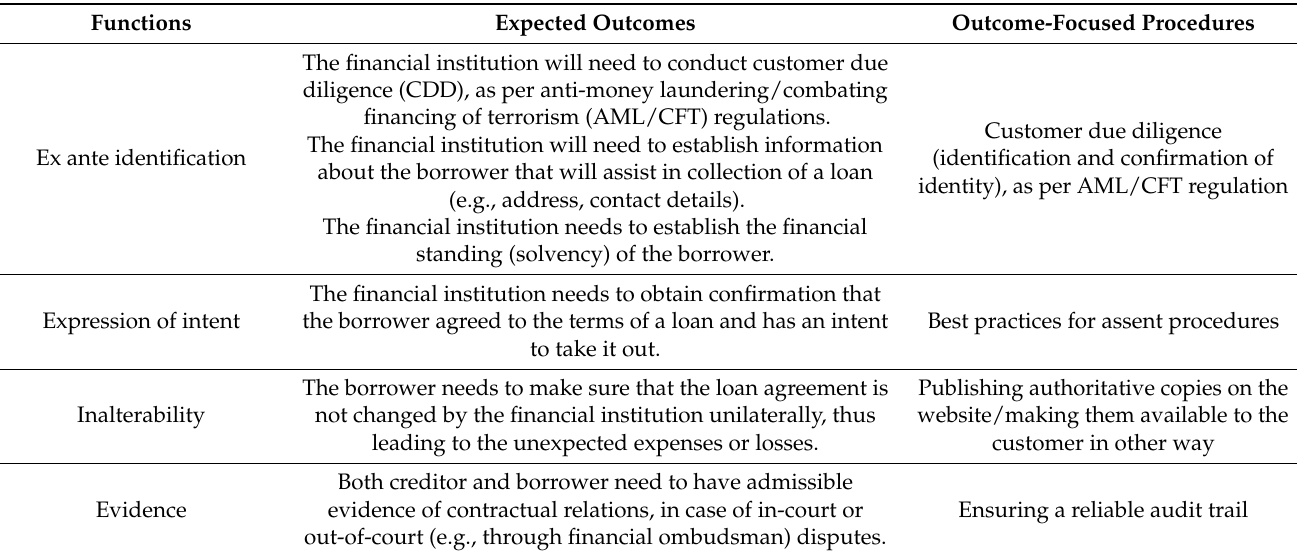
Table 5. Signature functions and corresponding outcomes and procedures in case of